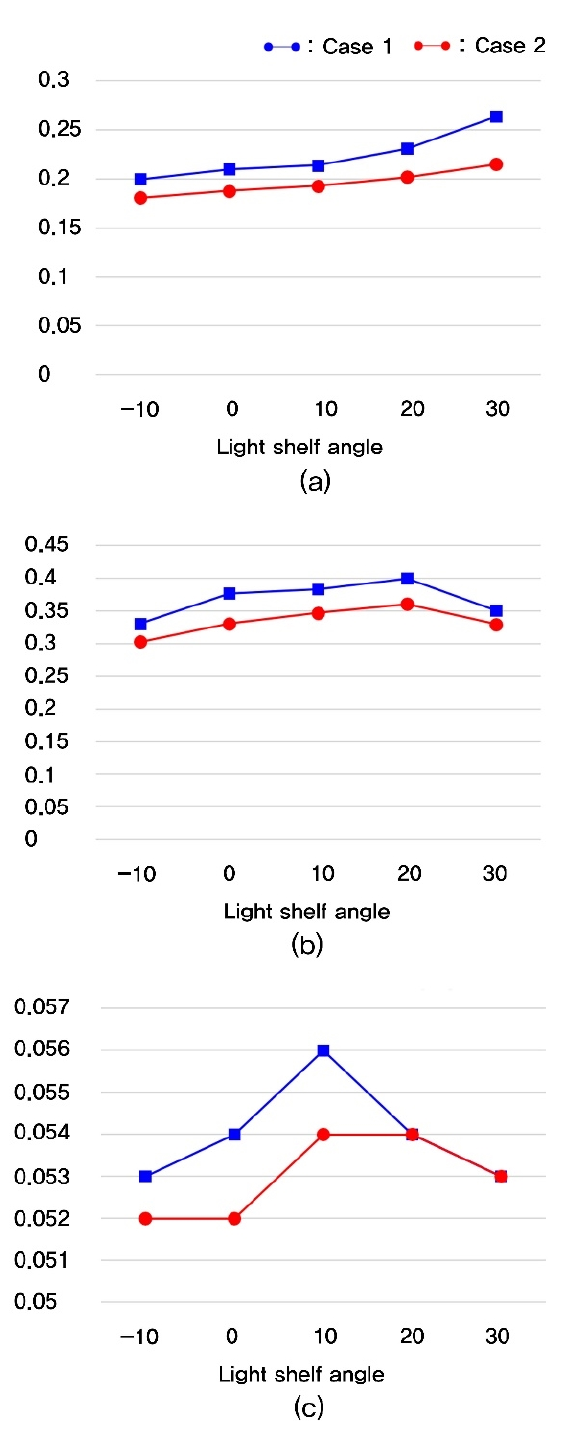
Figure 11. Case 1 and Case 2 indoor uniformity analysis: ( a ) Summer, ( b ) Mid-season, ( c ) Winter.